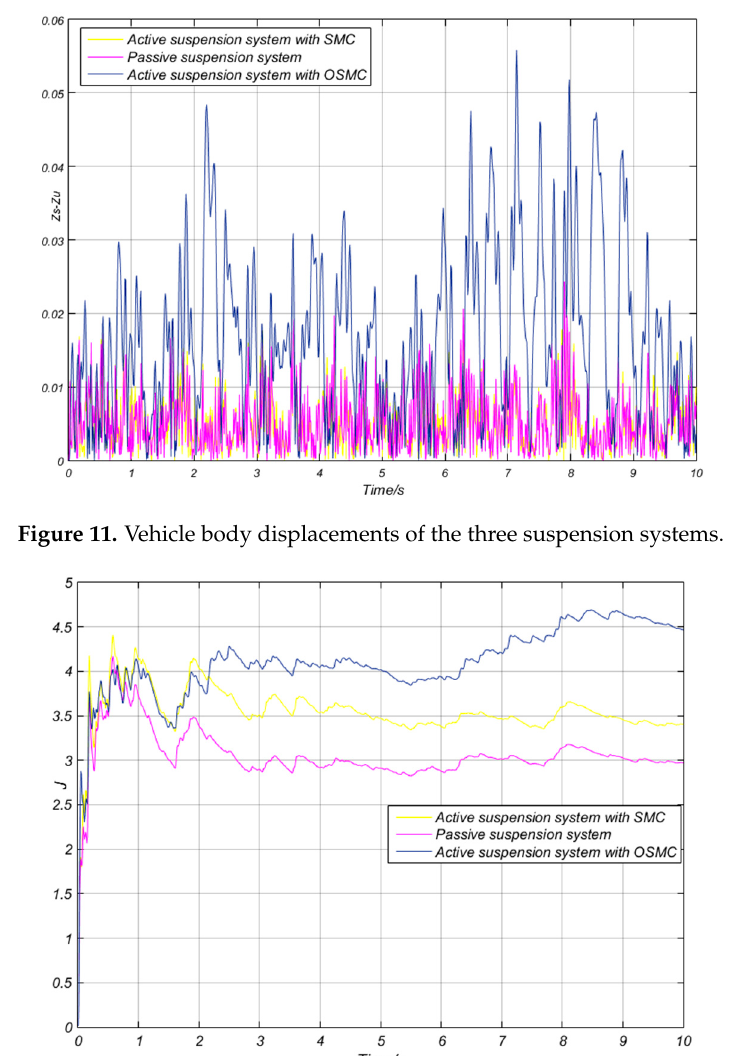
Figure 10. Different wheel hops of the three suspension systems.